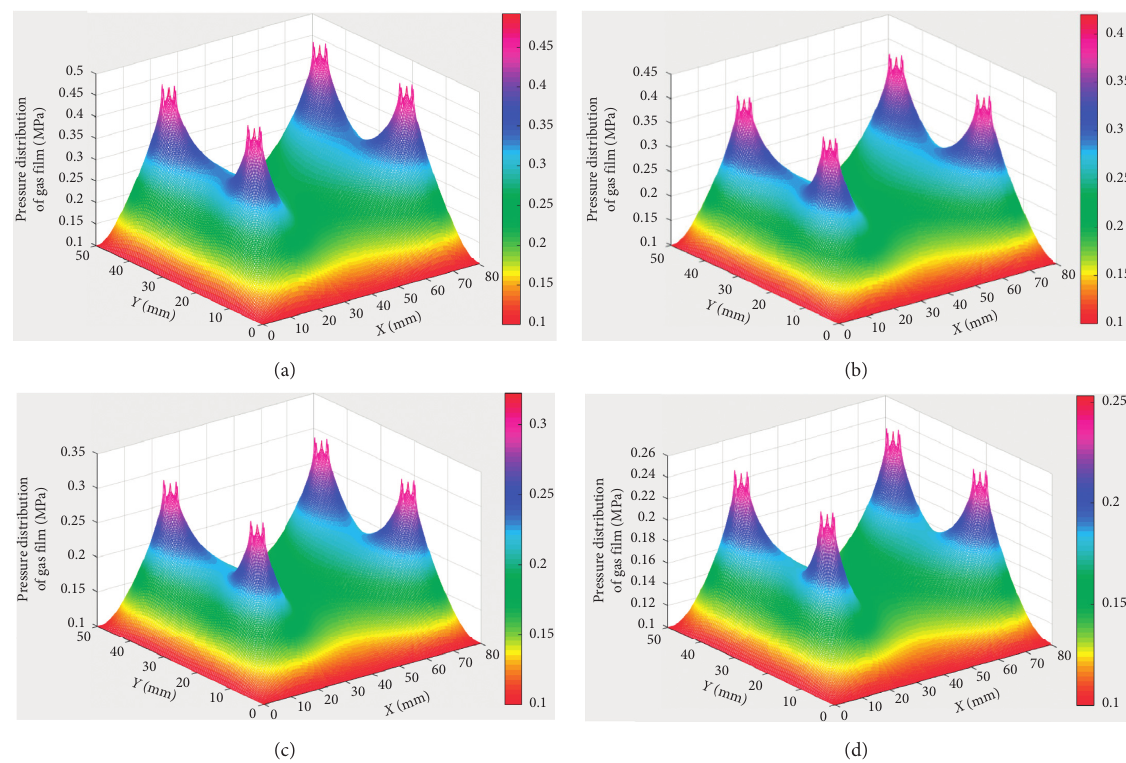
Figure 5: Diagram of gas film pressure distribution: (a) h � 10 μ m; (b) h � 20 μ m; (c) h � 30 μ m; (d) h � 40 μ m.